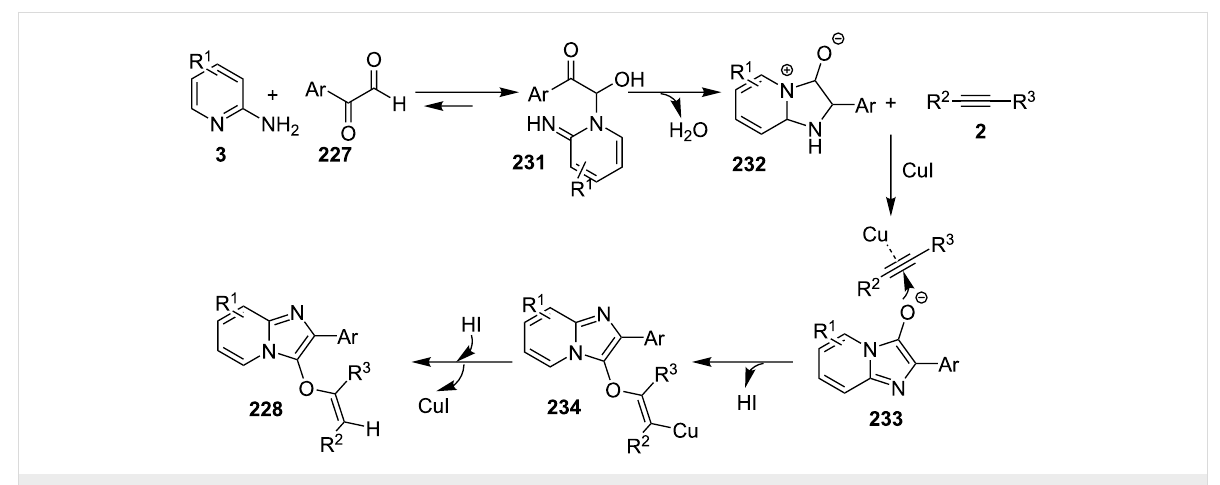
Scheme 79: Proposed mechanism for vinyloxy-IP